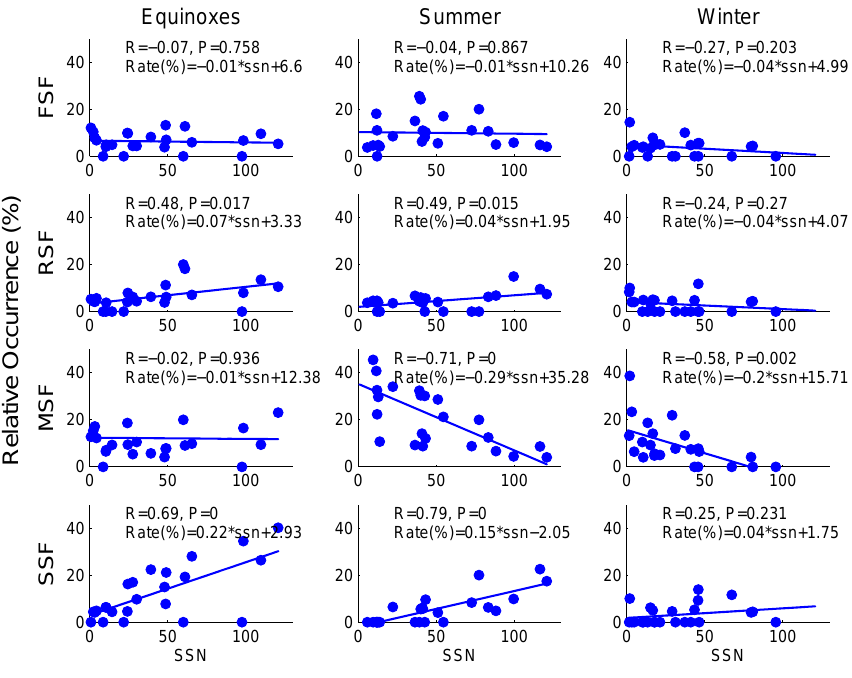
Fig. 4. Mean nocturnal monthly relative occurrence of each type SF observed at Hainan station during the magnetically quiet conditions in the different seasons from March 2002 to February 2008 scatter (big dots) with SSN. The straight lines denote the least squares fit to the relative occurrence of each type SF with SSN. The correlation coefficients R , P-values and fitting curve functions are also